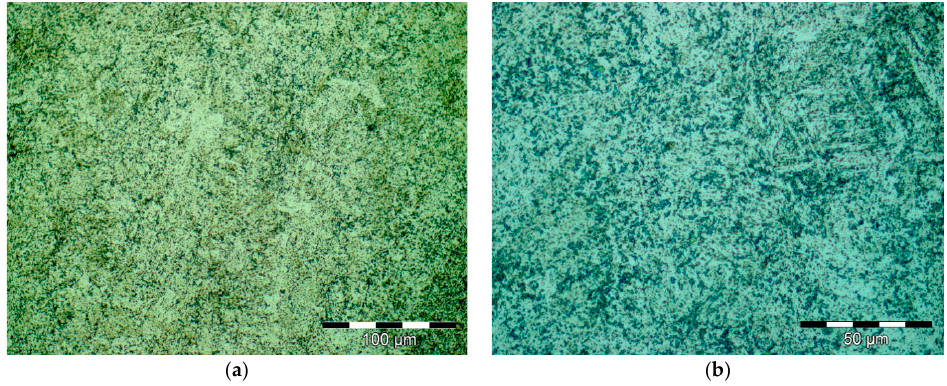
Figure 12. Optical microscopy images from secondary heat treatment; 500× magnification ( a ) 1000× ( b ).